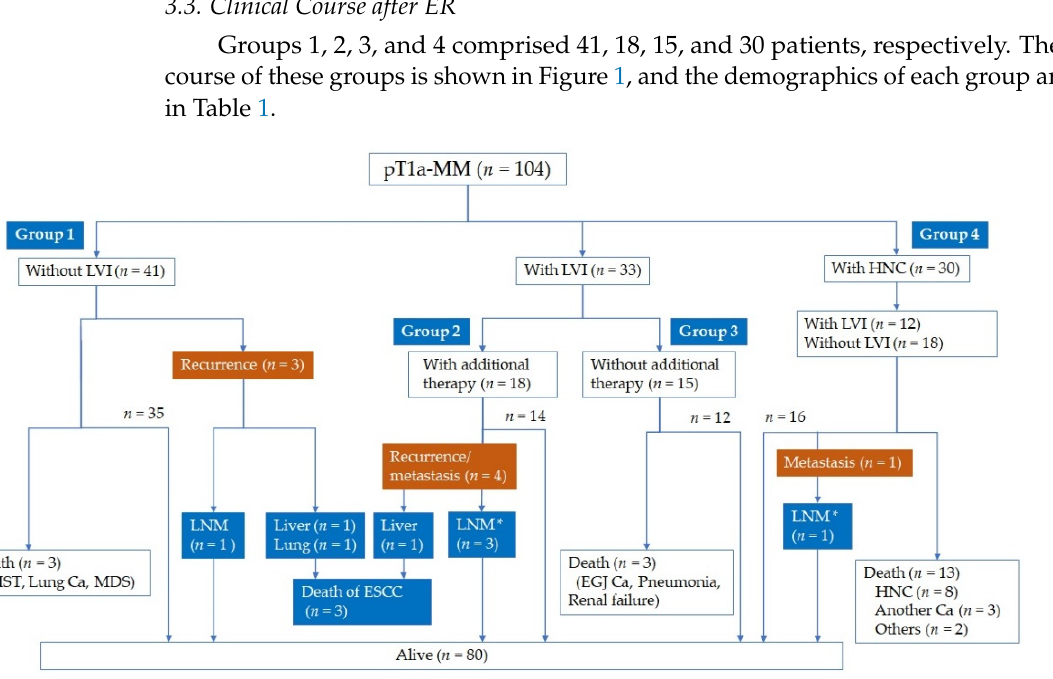
Figure 1. The clinical course of patients. LNM, lymph node metastasis; MDS, myelodysplastic syndrome; EGJ Ca, esophagogastric junctional carcinoma; Ca, carcinoma. * surgical resection as additional prophylactic therapy revealed LNM.